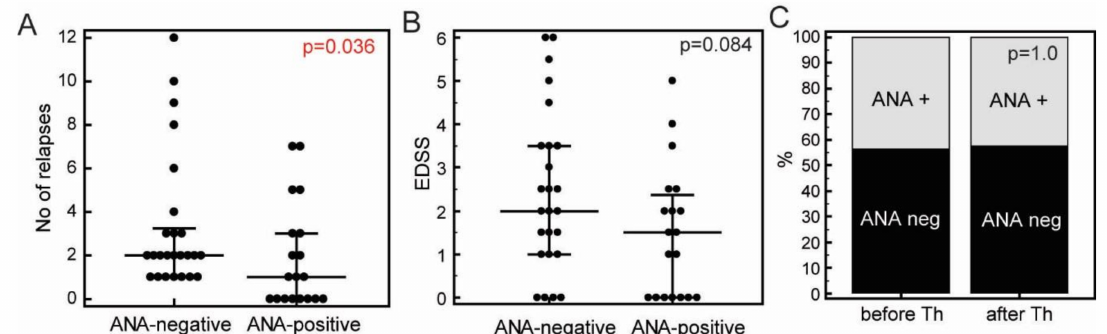
Figure 1. Total number of relapses ( A ) and expanded disability status scale (EDSS, B ) in ANA-negative ( N = 25) and ANA-positive ( N = 19) patients with RRMS, and relative frequencies of ANA in groups of patients whose samples were taken before the initiation of corticosteroid therapy (before Th, N = 16), and within 24 h after the initiation of therapy (after Th, N = 28, C ). ANA positivity was determined using HEp-2 IIF test (EUROIMMUN). Markers, individual patients’ values, horizontal lines and